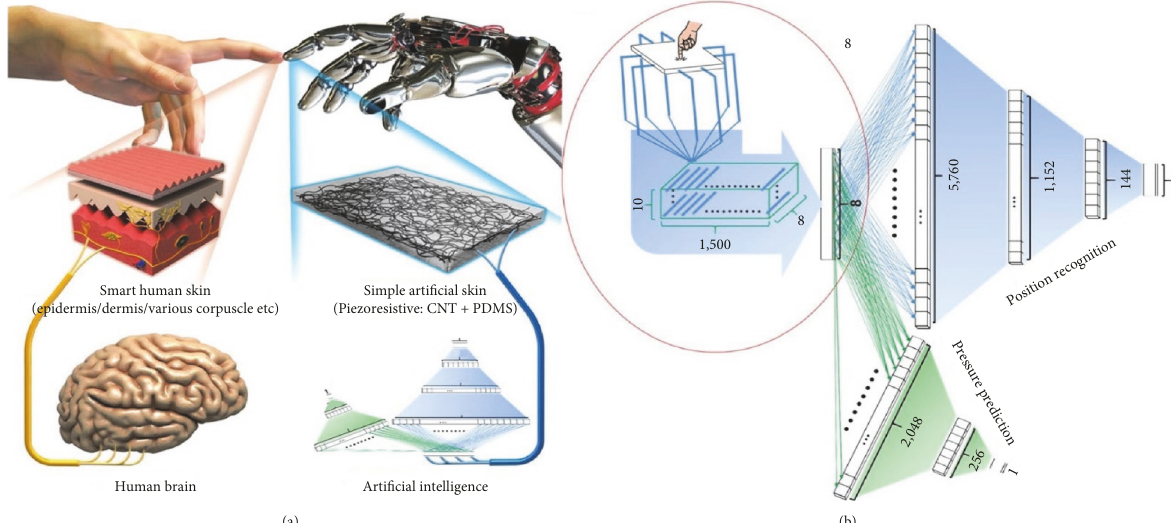
Figure 8: The schematic illustration of basic concept for e-skin and DNN architecture for reliable sensing. (a) A schematic elucidating the comparison between the human skin and the proposed e-skin. (b) The DNN architecture for tactile sensing (reprinted from Ref. [105] with permission, copyright 2017, Nature publishing group).